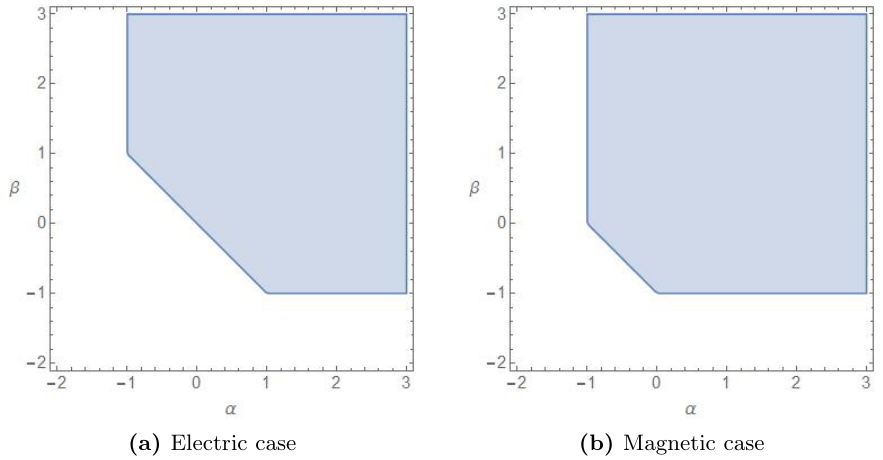
Figure 1. Conditions for scaling of scalar (cid:12)elds in Electric and Magnetic